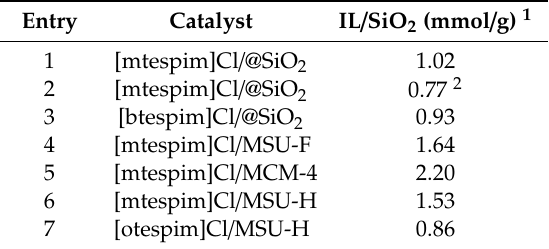
Table 2. The number of functional groups attached to the supports.